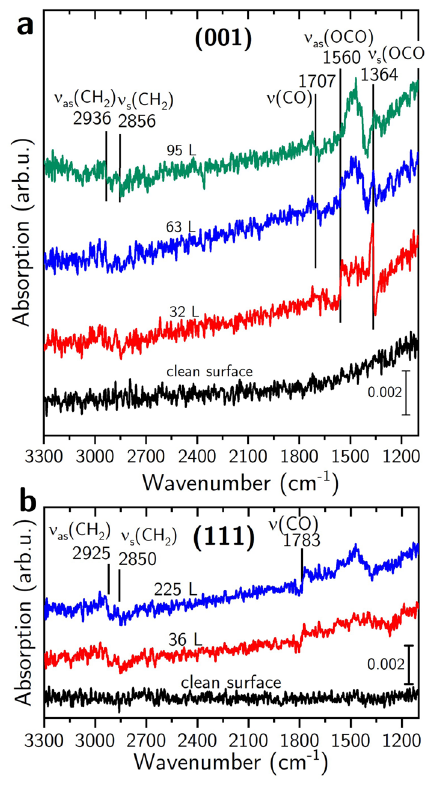
Fig. 4 FT-IRRAS of adsorbed OLAC on magnetite. p-polarized FT-IRRA spectra of OLAC on the two magnetite surfaces. OLAC exposure on magnetite (001) (a) and (111) (b) was done at 7 ⋅ 10 − 8 and 2 ⋅ 10 − 7 mbar, respectively. See main text for more